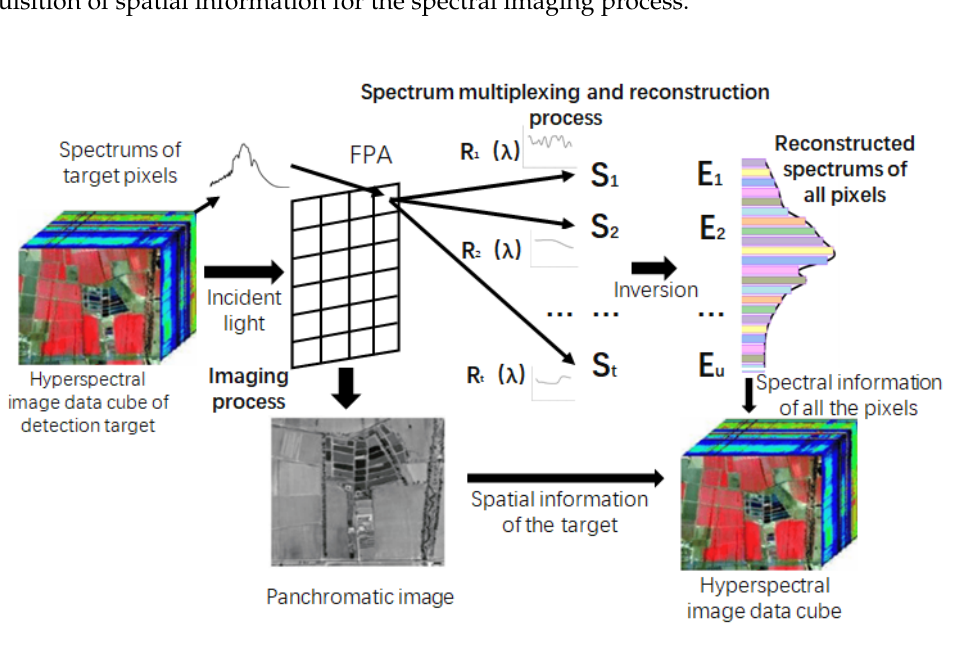
Figure 3. Broad-spectrum multi-channel spectral imaging